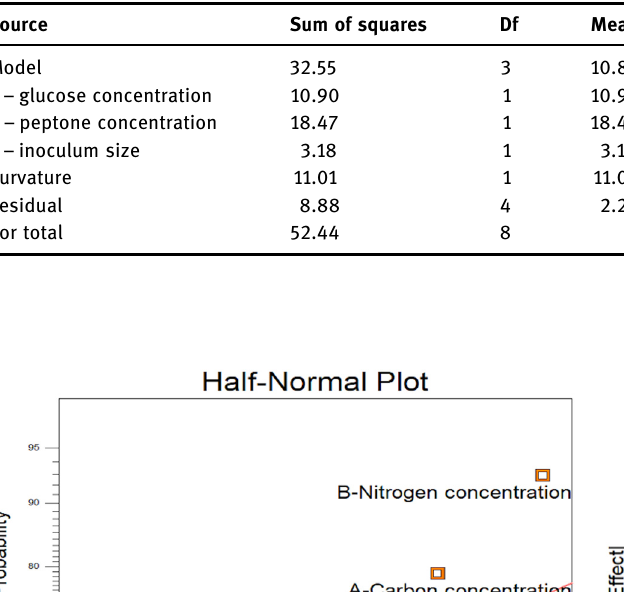
Table A1: ANOVA table of the e ff ect of di ff erent concentrations of glucose and peptone and di ff erent inoculum sizes on BC yield ( g/L ) by